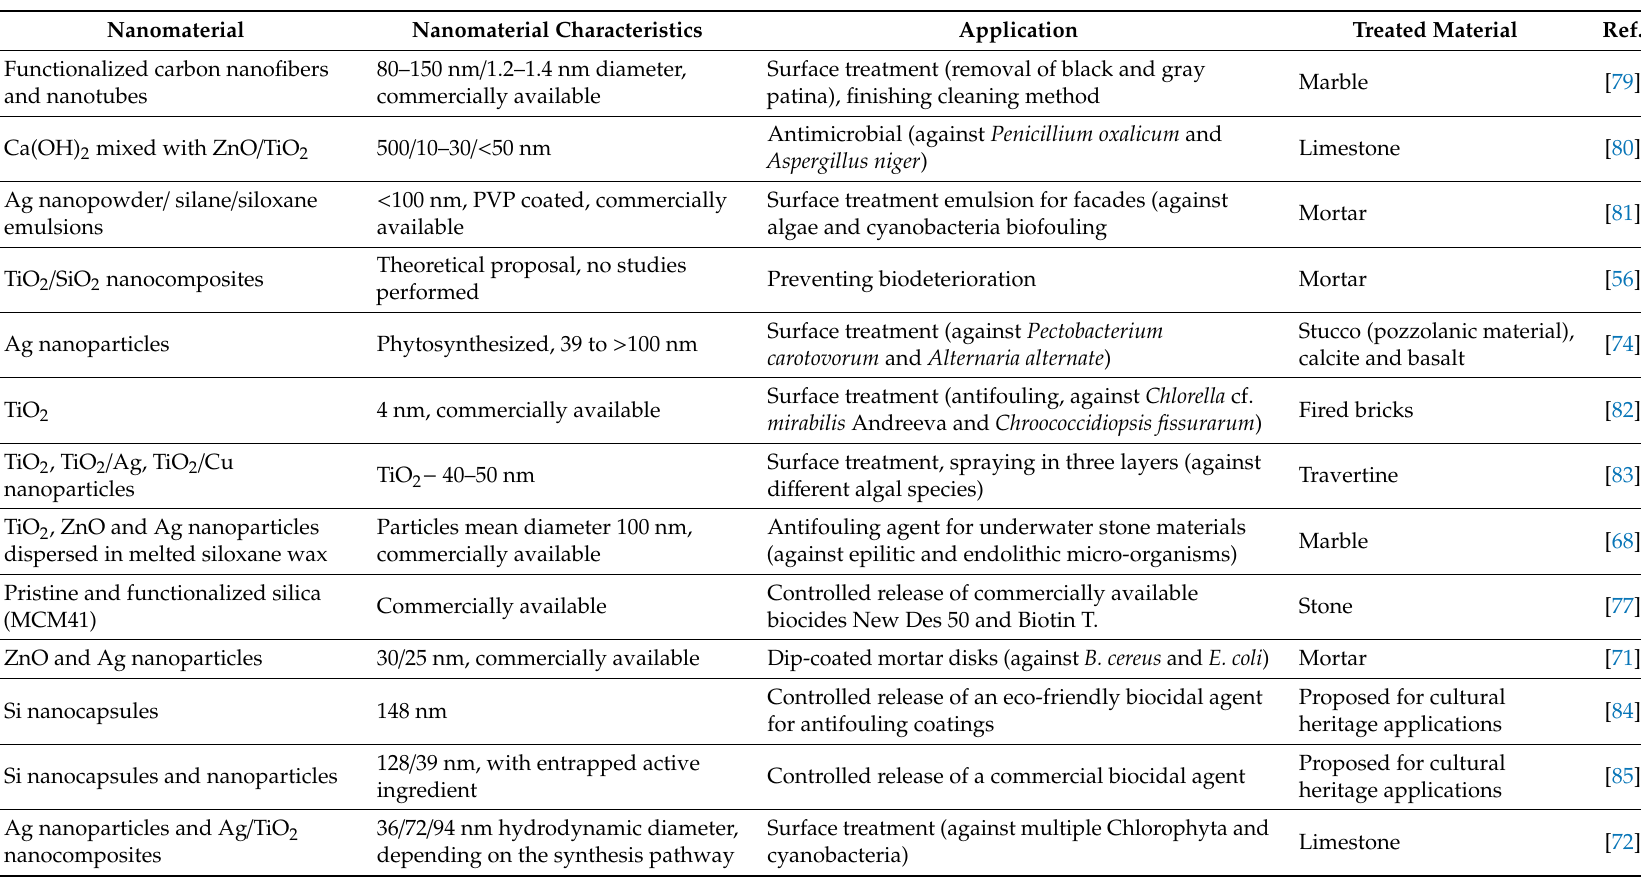
Table 4. Nanomaterials applied as biocidal agents in cultural heritage conservation (references presented in chronological